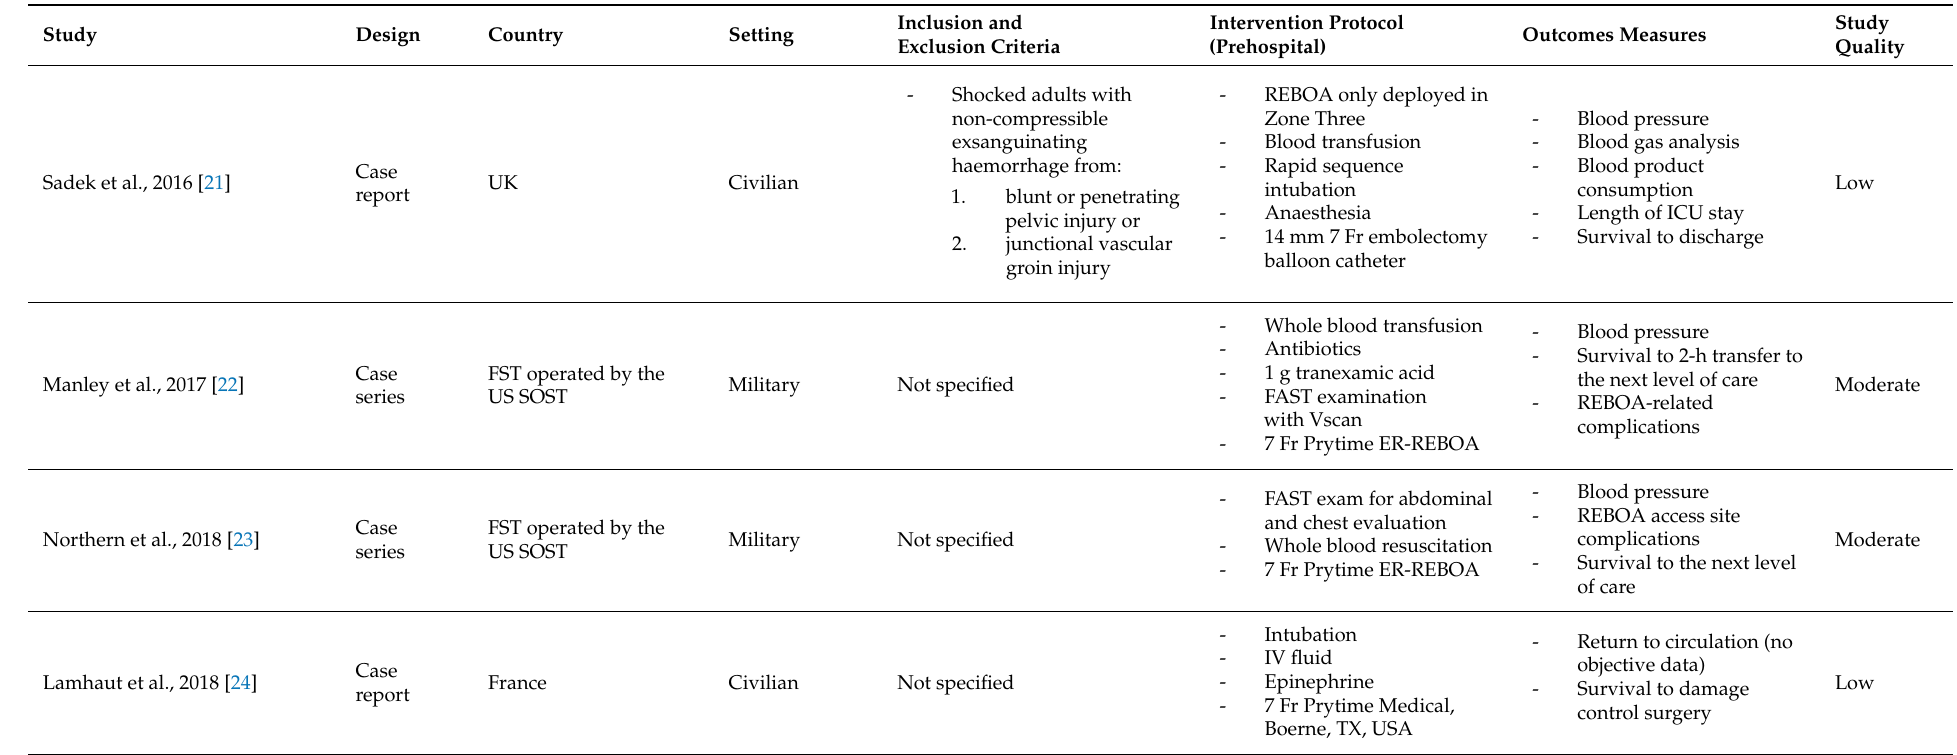
Table 3. Characteristics of the included studies in chronological